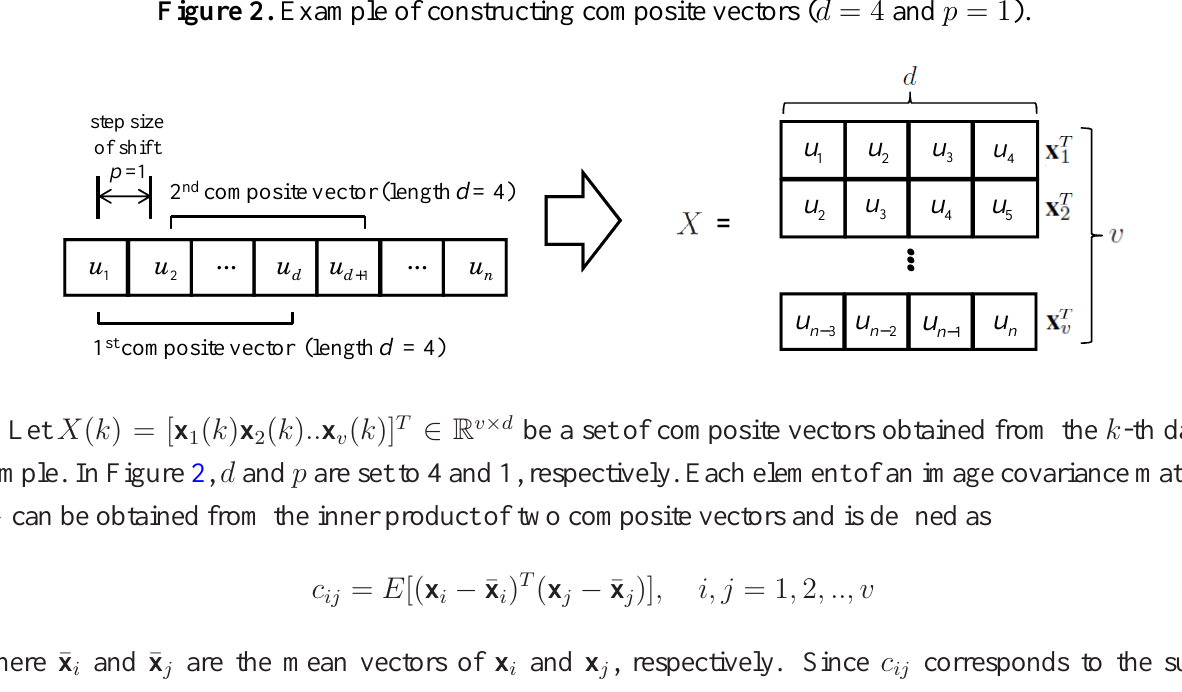
Figure 2. Example of constructing composite vectors ( d = 4 and p = 1